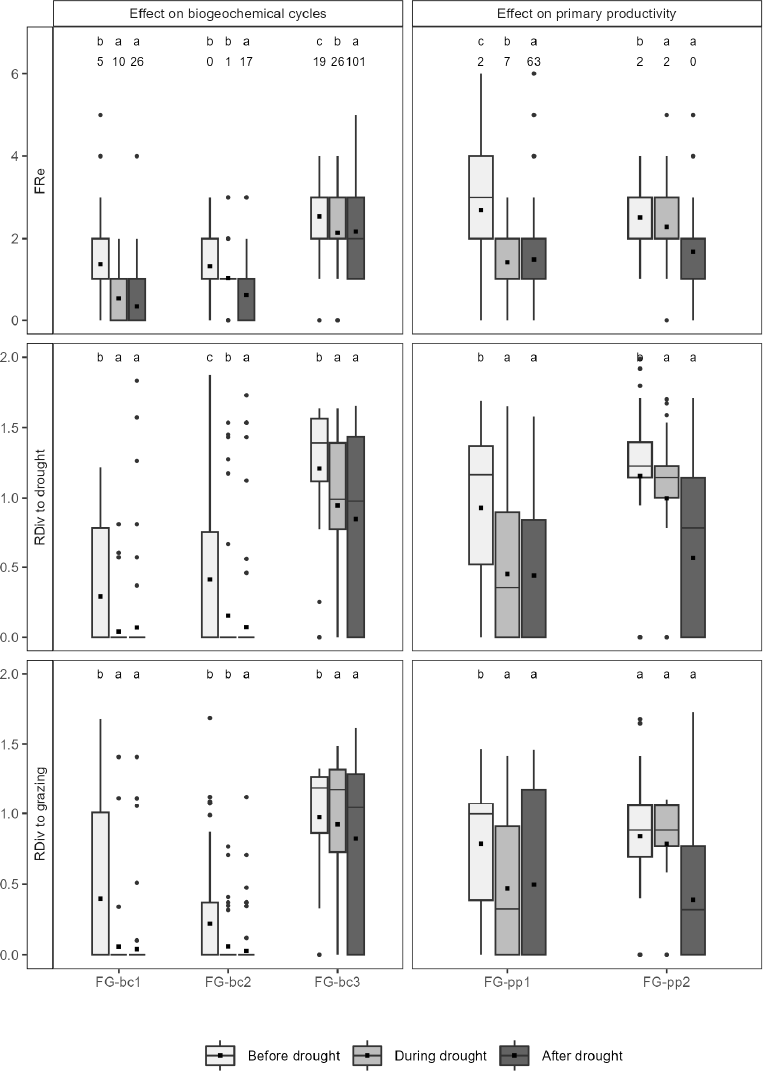
Figure 5. Evolution of FRe and RDiv to drought and grazing, for primary productivity (FG-pp) and biogeochemical cycles (FG-bc) ( n = 282 plots; 78 in 1970–1971, 49 in 1972–1984, and 139 in 2015). The means are represented by the squares. The letters indicate the differences according to the Wilcoxon’s pairwise tests ( p < 0.05) within each group. The numbers on the two FRe plots indicate the number of records with no species for each FG and each period.